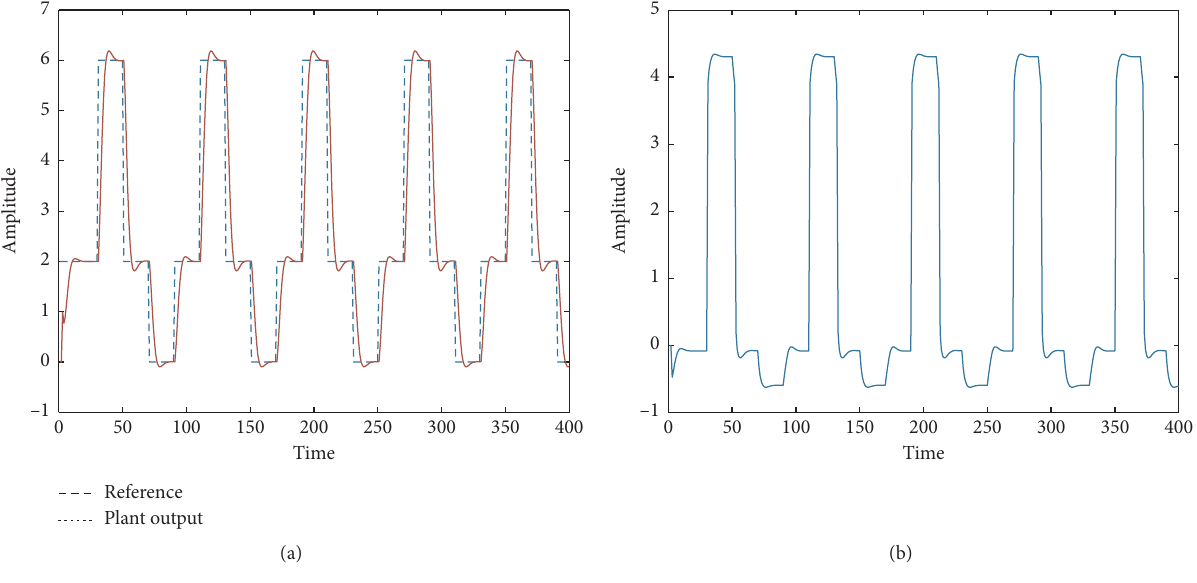
Figure 7: (a) Plant output. (b) Control input.